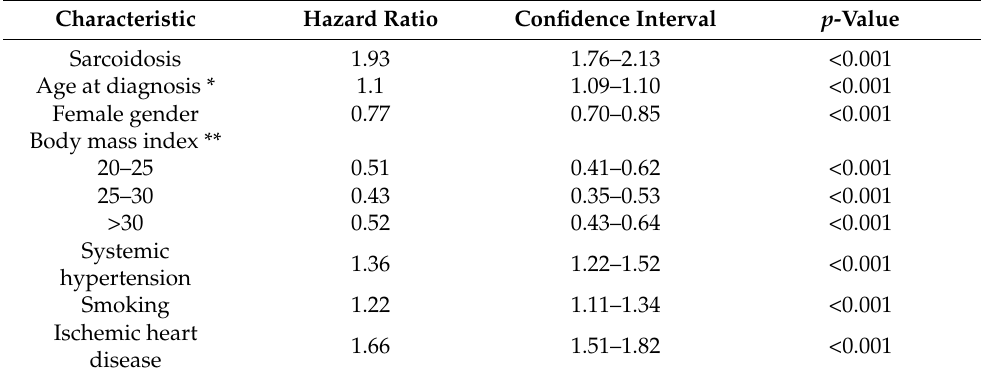
Table 3. Cox proportional hazards analysis for variables associated with all-cause mortality.